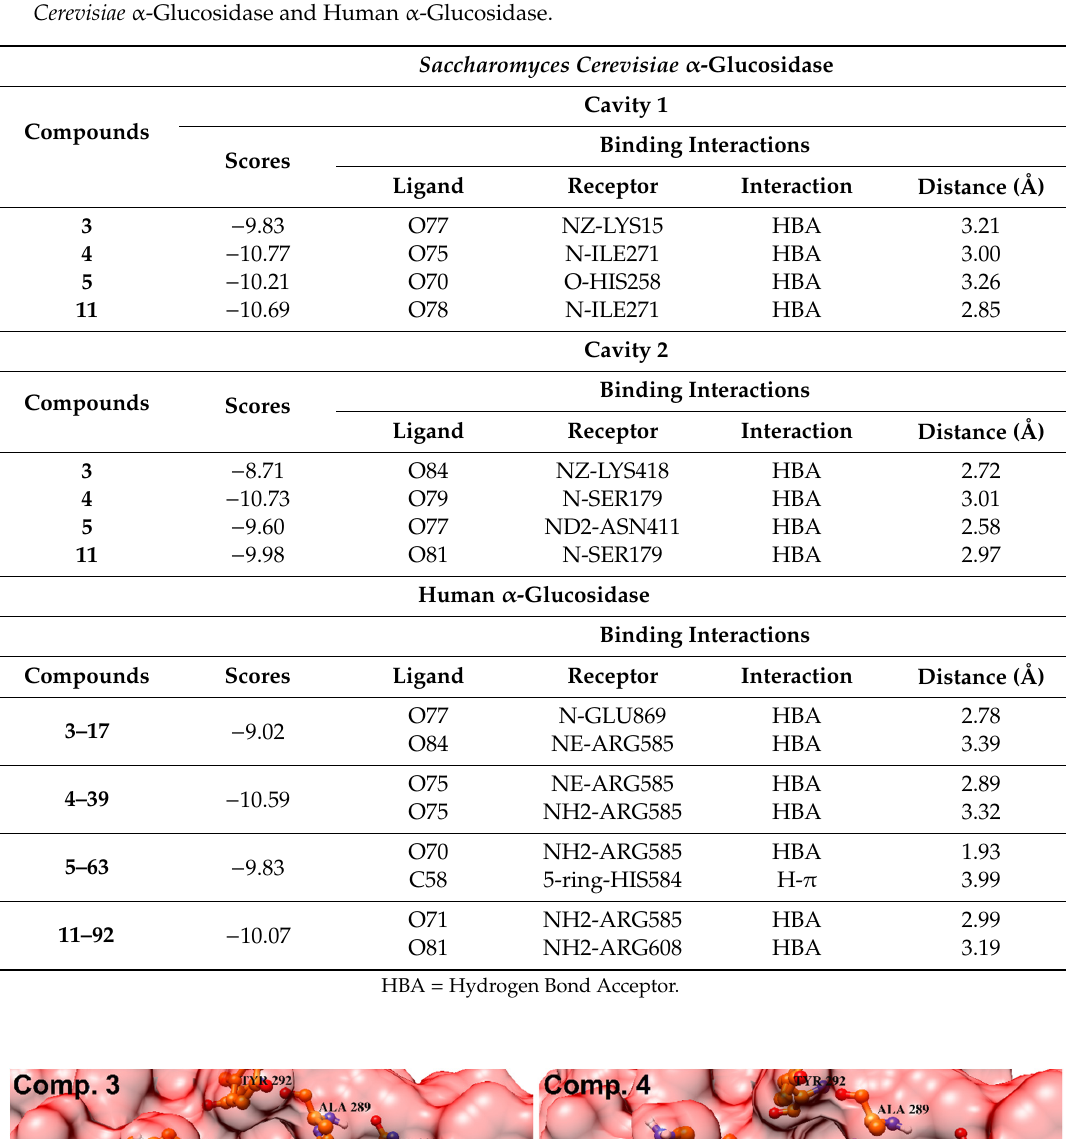
Figure 9. Three-dimensional structure of Human α -glucosidase. The active site and the allosteric binding sites are also demonstrated. The binding mode of acarbose (yellow stick model) is shown in the active site of human α -glucosidase. The binding mode of compounds 3 – 5 and 11 (shown in